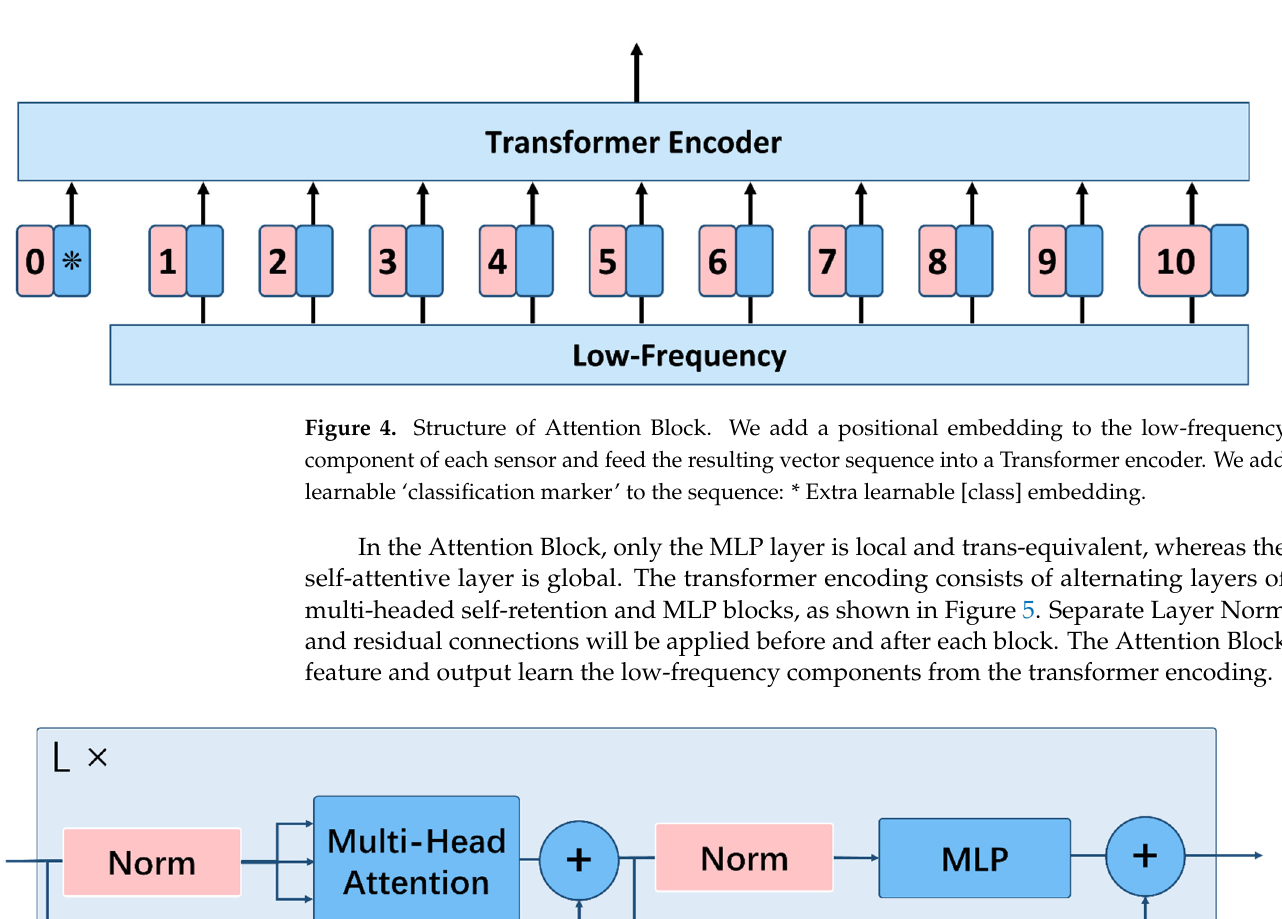
Figure 4. Structure of Attention Block. We add a positional embedding to the low-frequency com- ponent of each sensor and feed the resulting vector sequence into a Transformer encoder. We add learnable ‘classification marker’ to the sequence: * Extra learnable [class] embedding.